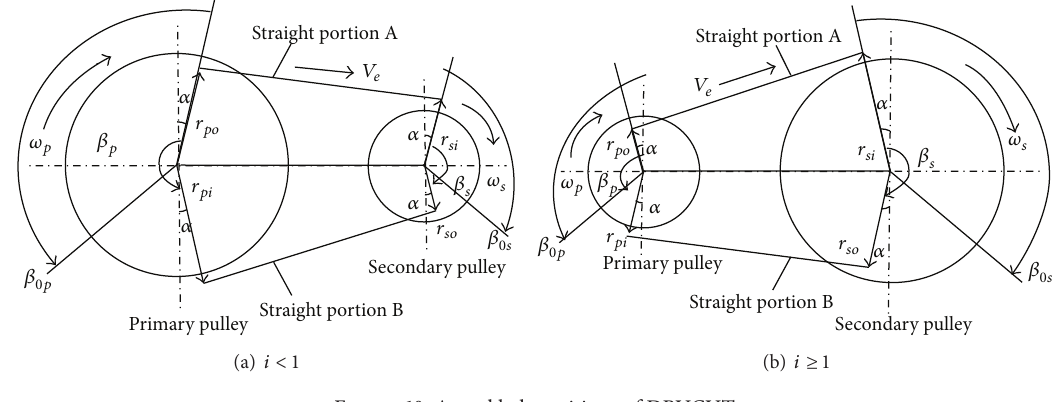
Figure 10: Actual belt positions of